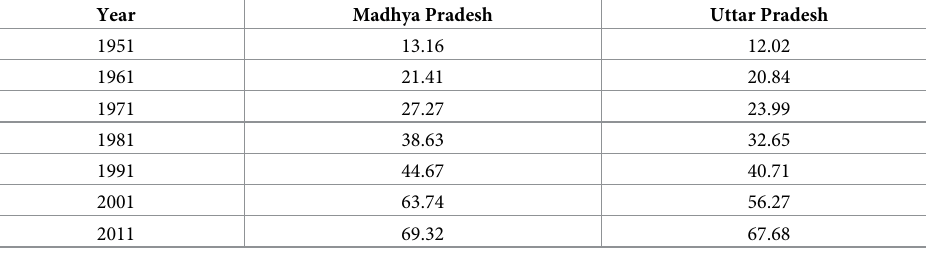
Table 3. Changes in literacy rates (%) in Madhya Pradesh and Uttar Pradesh.